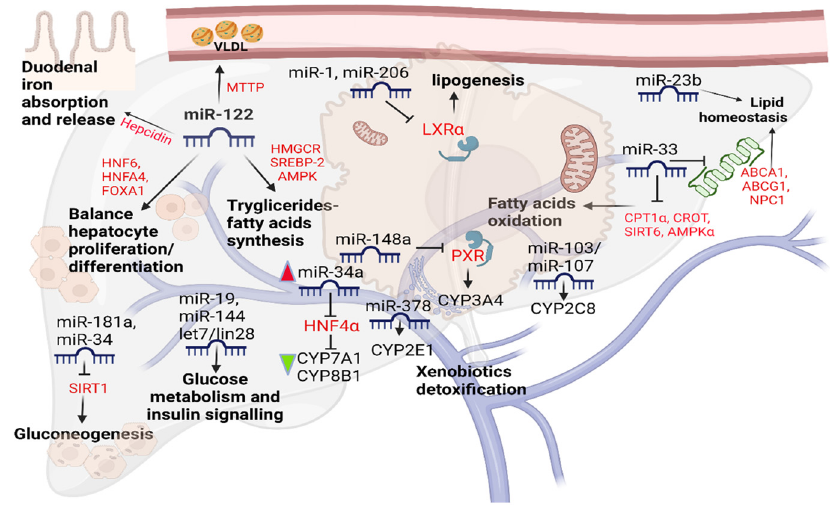
Figure 1. miRNAs maintaining metabolic homeostasis.